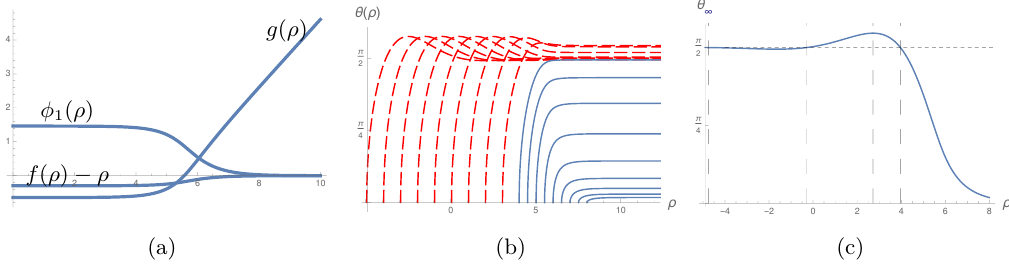
. The IR scaling 2